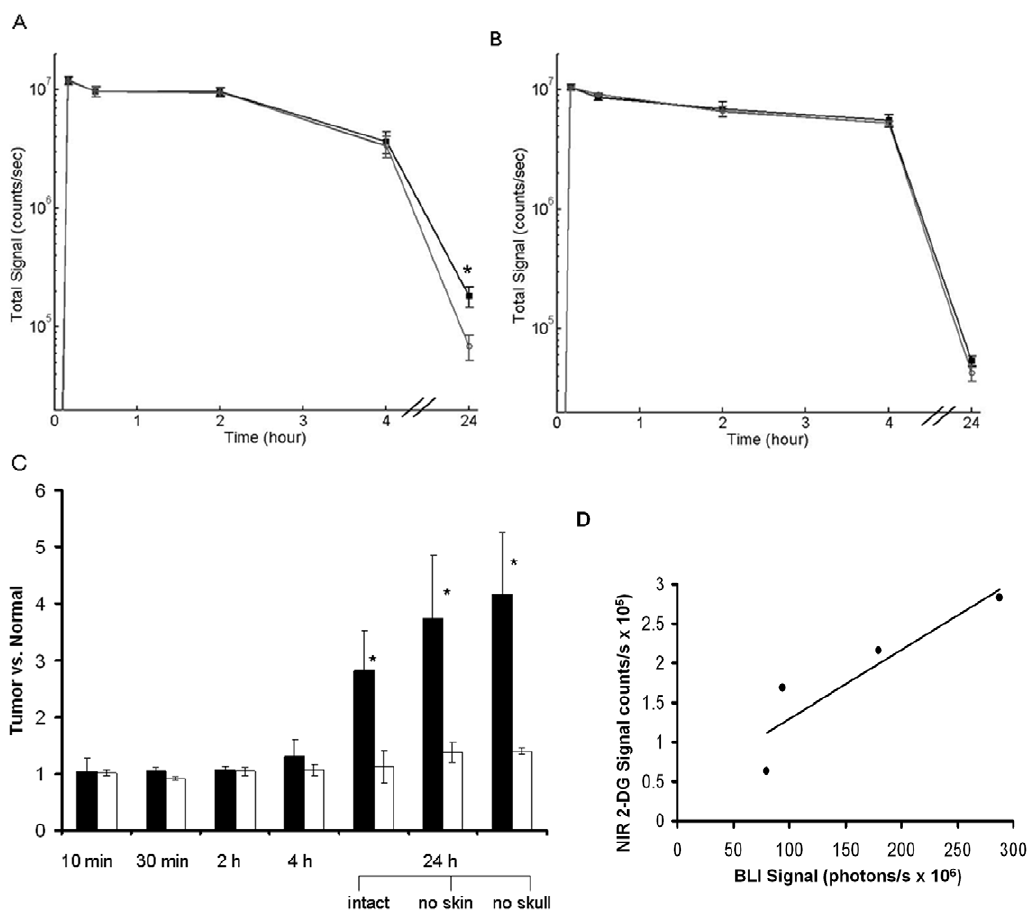
Figure 4. Time course of light intensity of invivo fluorescence imaging of the 2-DG dye. Mean light intensity curves shown for the tumor side (solid square) and the contralateral normal brain (open circle) of intact mice. A. For the 2-DG dye (n=4), the curves were essentially identical for the first 4 h post injection, but after 24 h, there was a significant difference (1.8 6 10 5 6 0.2 6 10 5 versus 0.7 6 10 5 6 0.4 6 10 5 ; p , 0.05). B. In contrast, the control carboxylated dye showed no difference during the whole course (n=3). C. Time course of tumor to normal tissue ratio (TNR) showing a significantly higher TNR in the 2-DG dye group (mean =2.8 6 0.7; solid bar) versus the control group of the control dye (n=3; 1.1 6 0.3; open bar) 24 h after injection (p , 0.05). An even bigger TNR was obtained in the 2-DG group by removing the scalp (3.7 6 1.1) or skull (4.1 6 1.1). D. A strong linear correlation was observed between light intensity of in vivo BLI and 2-DG NIR imaging of intracranial tumors (r=0.9).